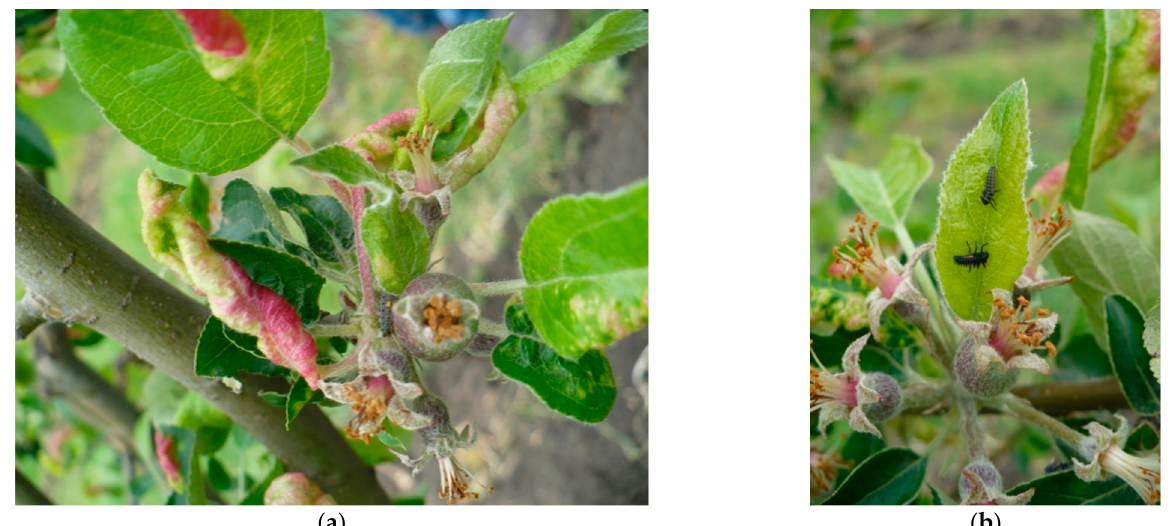
Figure 3. Organic apple orchard at the Shcherbakov farm: ( a )—apple tree leaves affected by aphids; ( b )—release of ladybird larvae.